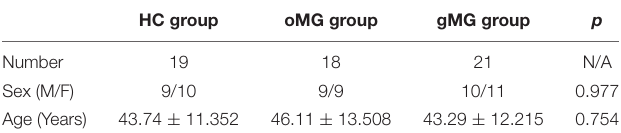
TABLE 1 | Clinical characteristics of